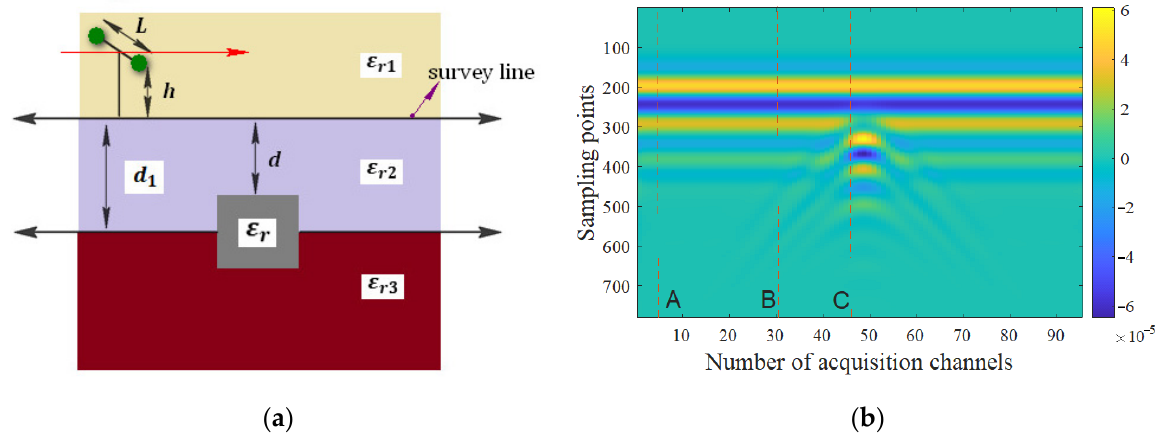
Figure 4. The original simulation model and the corresponding B-scan image. ( a ) Schematic diagram of GPR measurement. ( b ) Time accumulation B-scan image.